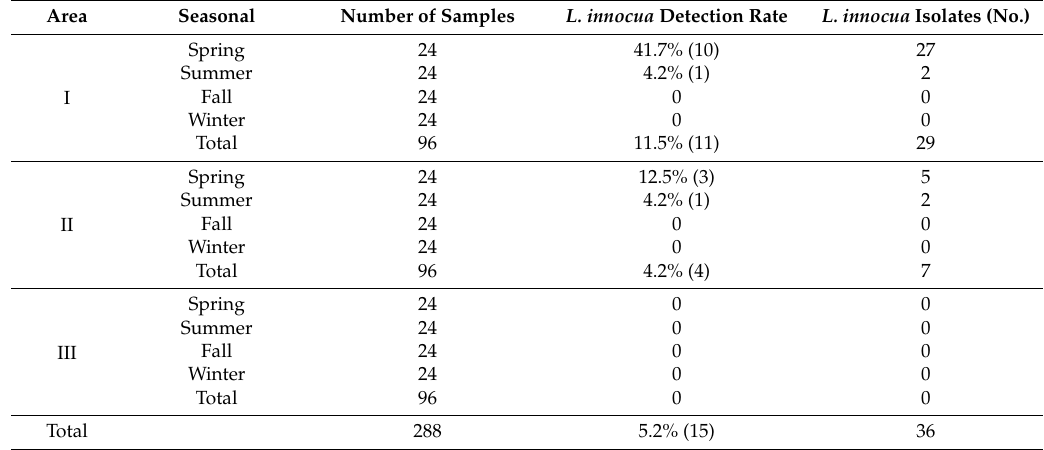
Table 1. L. innocua results for three sampling areas of 4